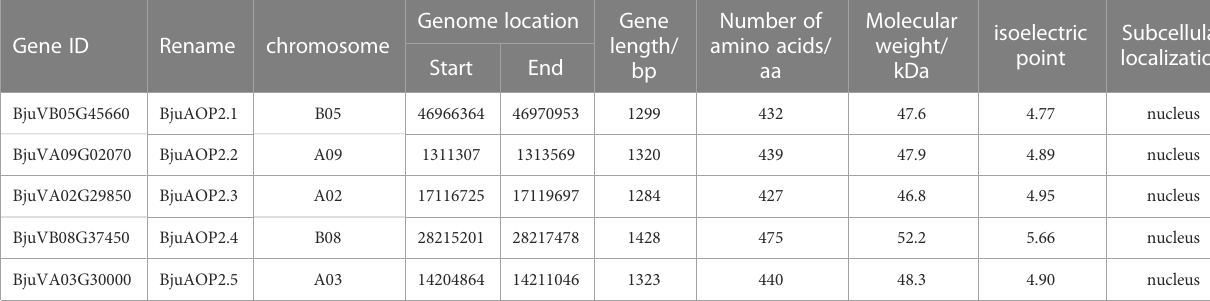
TABLE 1 Basic information of the BjuAOP2